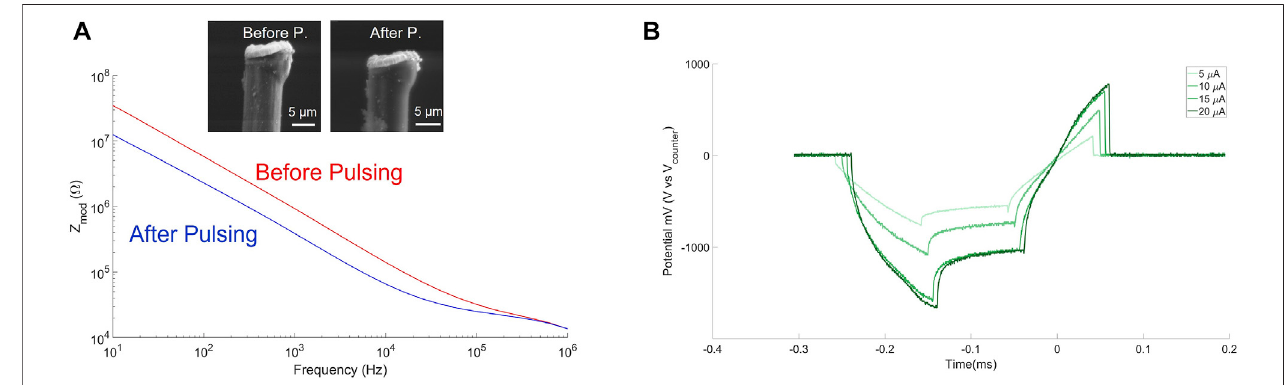
FIGURE7| PulsingtestofcellularscalePtIr-CF. (A) Impedancebefore(redsolidline)andafter(bluesolidline)pulsingforonePtIr-CF;asinsetSEMimageoftheCF before and after pulsing test. (B) Voltage transients when applying a cathodic fi rst biphasic pulse of 100 μ s duration and gap interphase, with current amplitudes from 5 to 20 μ